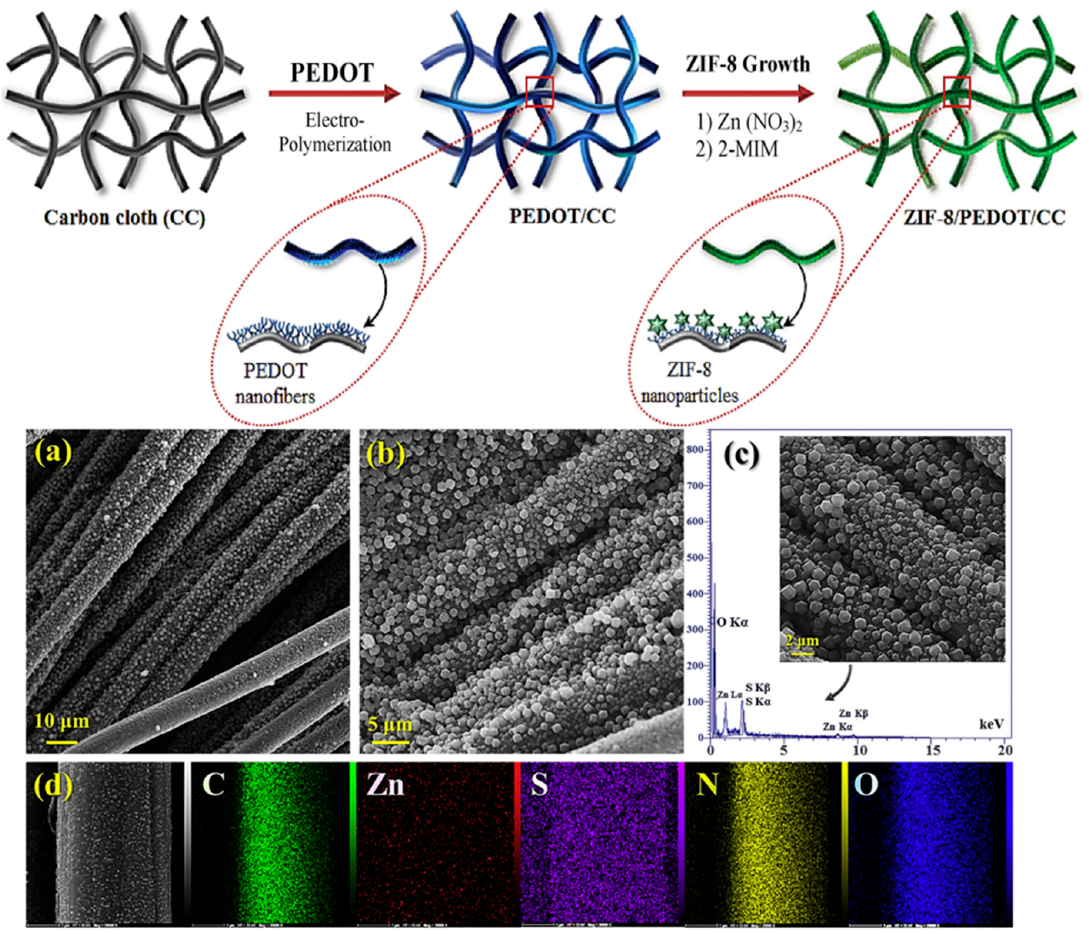
Figure 4. ( a ) Schematic representation of successive carbon cloth (CC) modification with a poly(3,4-ethylenedioxythiophene) (PEDOT) film and ZIF-8 nanoparticles. ( b ) Low- and ( c ) high-magnification SEM images and ( d ) EDX spectrum of ZIF-8 nanoparticles deposited on PEDOT-coated carbon fibers. ( e ) Elemental distributions of C, Zn, S, N, and O obtained for ZIF-8 / PEDOT / CC. Reprinted and modified with permission from ref. [62]. Copyright (2020)